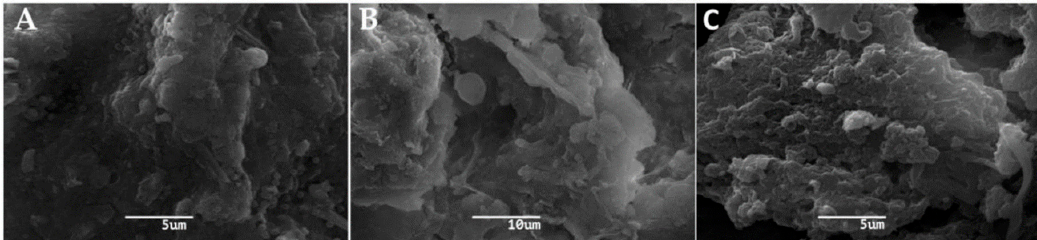
Figure 2. Scanning Electron Microscopy (SEM) of the reverse osmosis (RO) membrane of the south-central area dialysis centre showing the presence of biofilm. ( A ): initial segment of RO membrane. ( B ): middle segment of RO membrane. ( C ): final segment of RO membrane. The scale bar is 5 μ m, 10 μ m and 5 μ m, respectively.